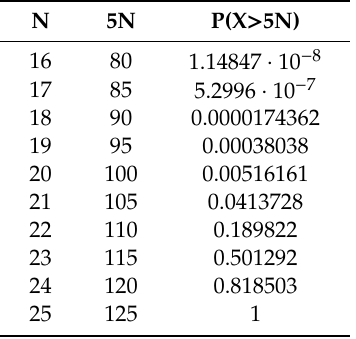
Table 1. Number of customers = 10N (k = 10).